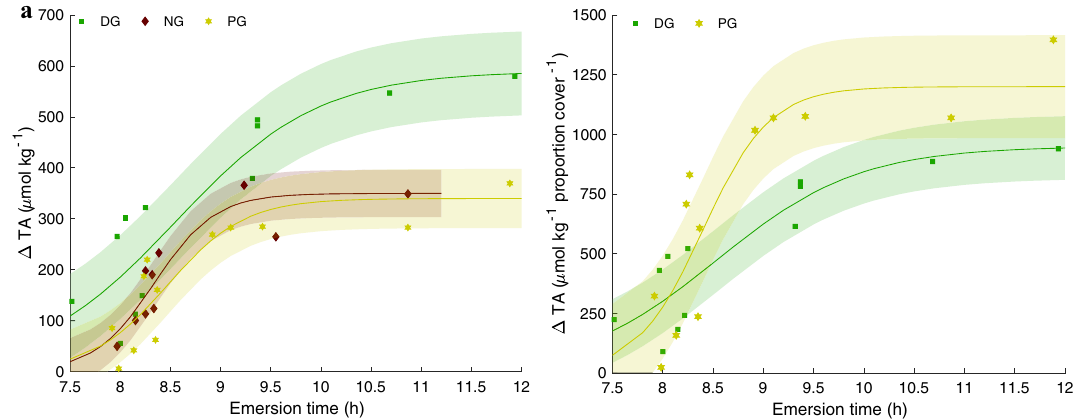
Figure 3. The ΔTA ( a ) and ΔTA per proportion of seagrass cover ( b ) as a function of emersion time for dense grass (DG), patchy grass (PG), and no grass (NG) pools. Highlighted region is the RMSE of modeled logistical fit.